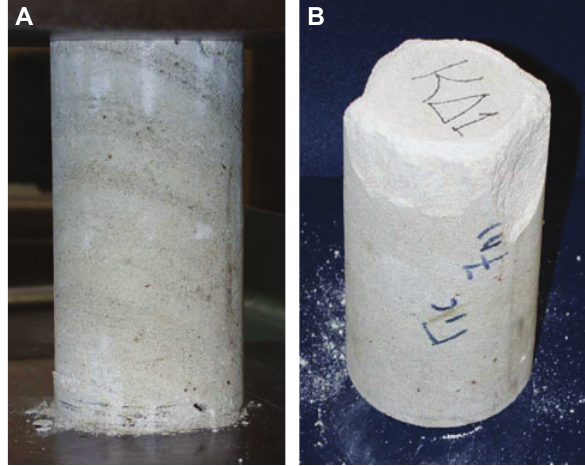
Figure 5 Characteristic tested specimens of the ring type rimming made from Kenchreae stone.